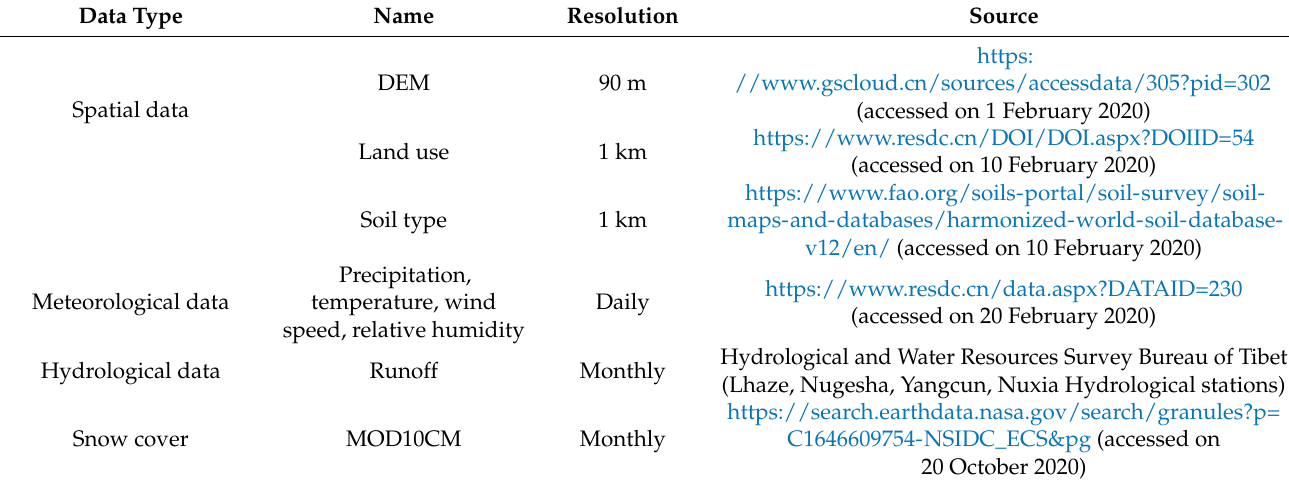
Table 1. Data used and corresponding sources.